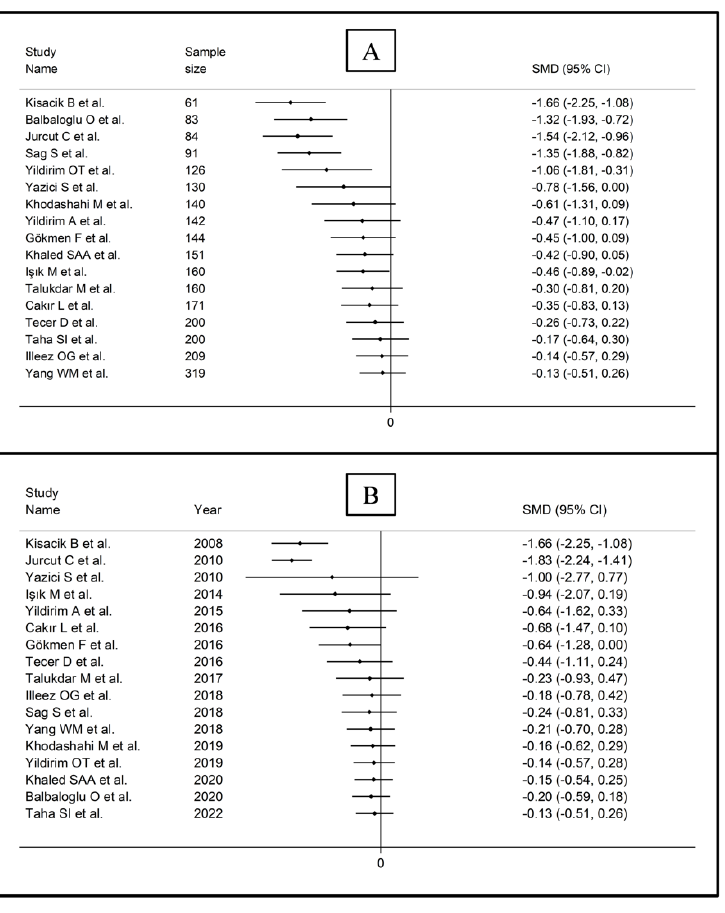
Figure 7. Cumulative meta-analysis of the mean platelet volume based on study design ( A ) and publication year ( B ). publication year ( B